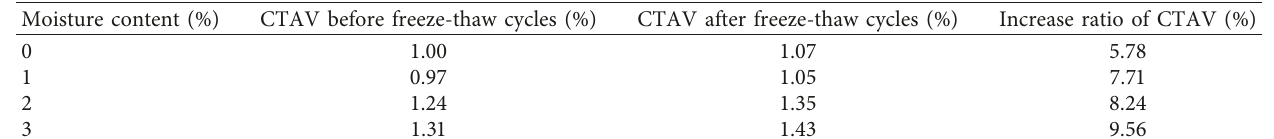
Figure 7: RH-WMA cut samples. Table 12: The increase ratio of CTAV of the RH-WMA cut samples through freeze-thaw cycles.